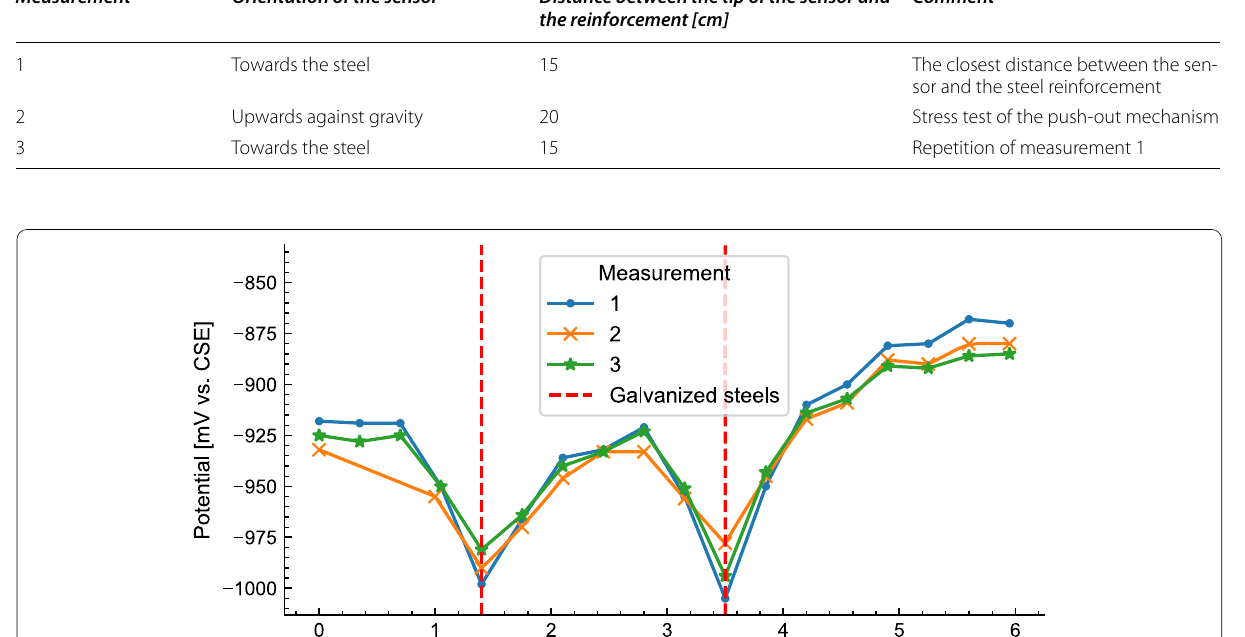
Table 1 Differences between the different measurements with the developed probe during the field experiment Measurement